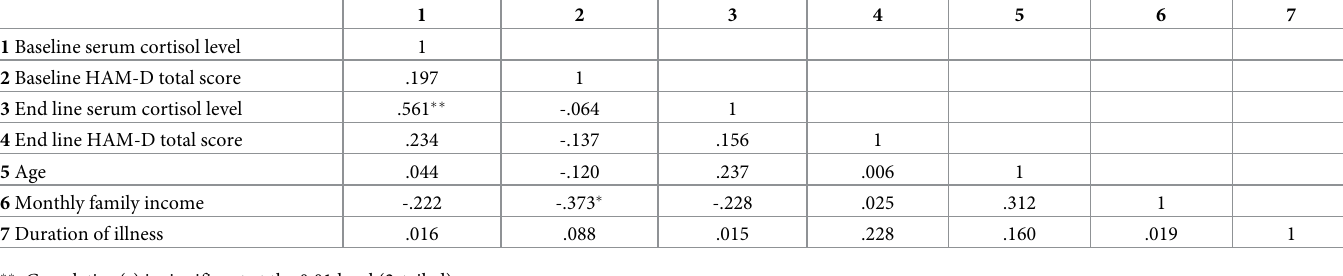
There is no significant mean change in serum cortisol level before and after treatment with t (33) = 2.02 and p = 0.052. However, baseline and end line serum cortisol levels were signifi- cantly correlated with r = .561 and p = .001. This corresponds to a coefficient of determination (R2) of 0.31, suggesting that about 31% of the variability of end line serum cortisol level can be explained by the relationship with baseline serum cortisol level. Result shows there is signifi- cant difference in HAM-D total score with t (33) = 5.67 and p < 0.001. However, there is no sig- nificant correlation between baseline serum cortisol level and baseline HAM-D score ment) serum cortisol level and HAM-D score (r = 0.21, p = 0.231). Table 2. Pearson correlations among serum cortisol level, HAM-D total score, age, income and duration of illness in patients with newly major depressive disorder in Jimma medical center, 2019(n =